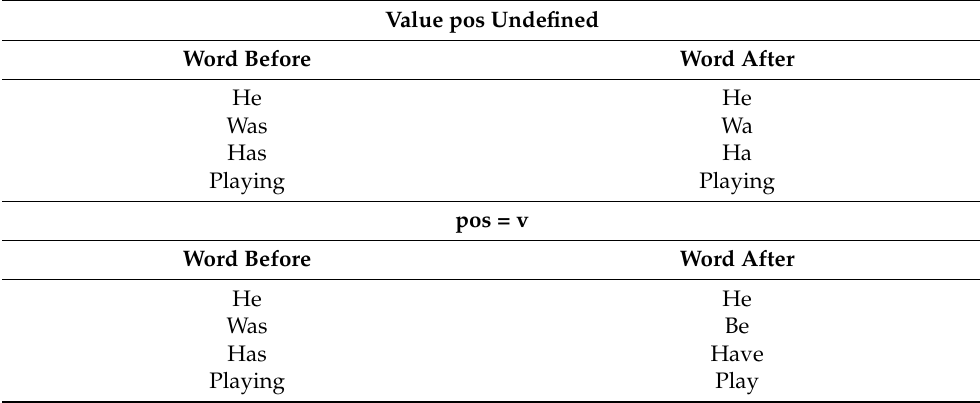
Table 2. Examples of lemmatization with